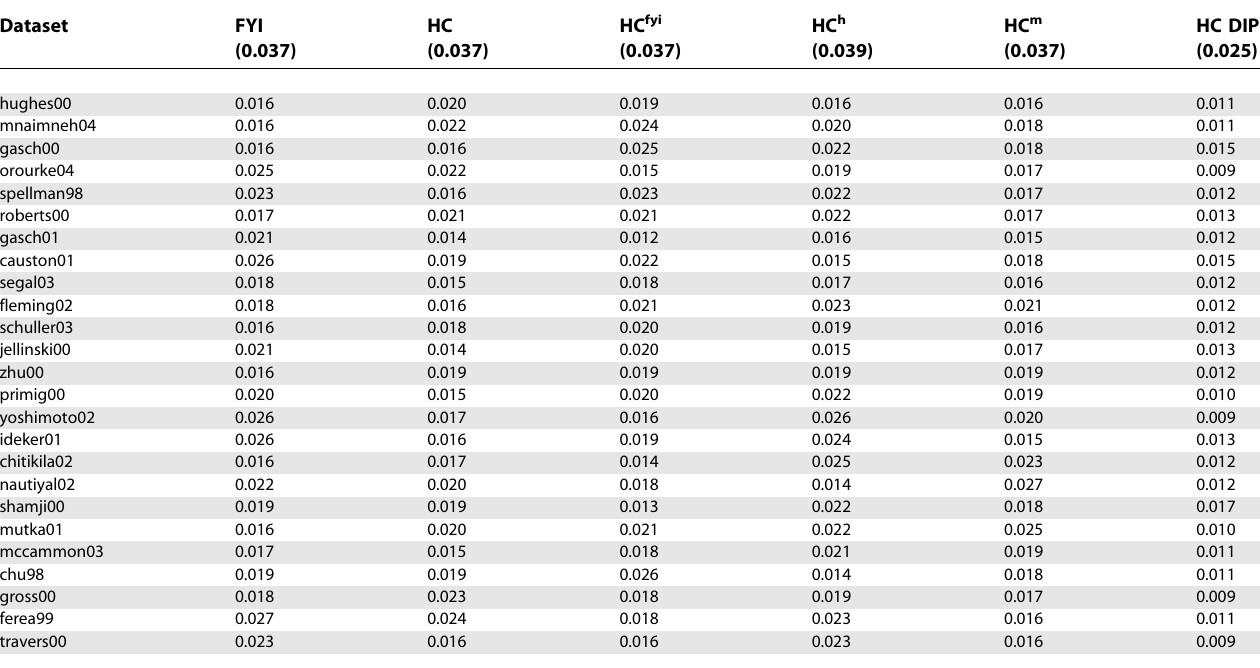
Table 1. Statistical Test for Multi-Modality in the Distribution of Neighbor Expression Correlation